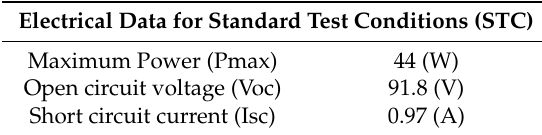
Table 2. Specifications of the a-Si transparent BIPV